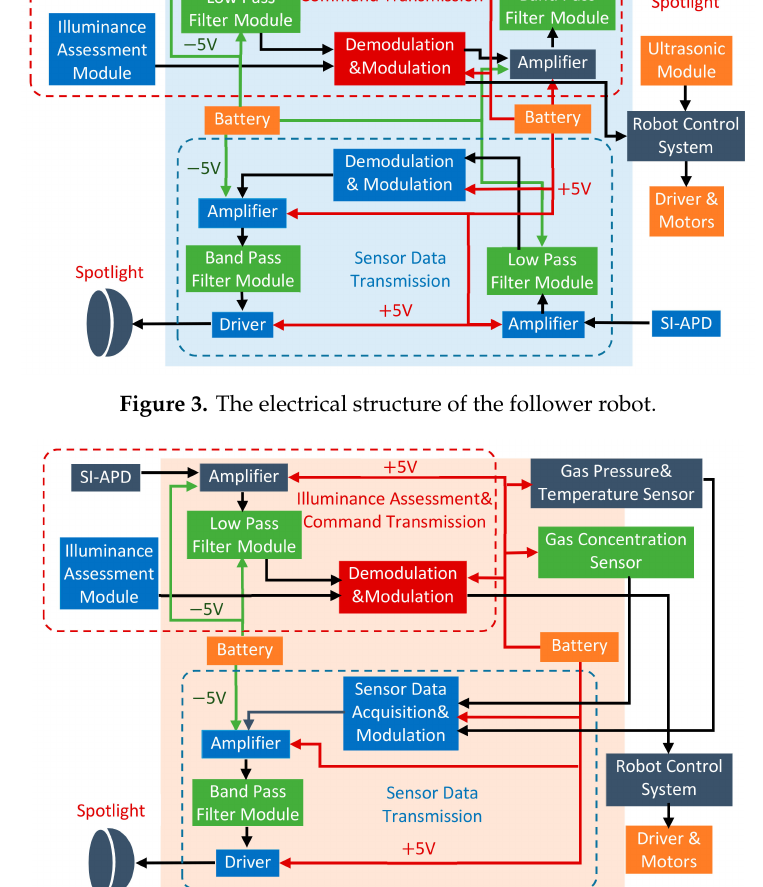
Figure 4. The electrical structure of the leader